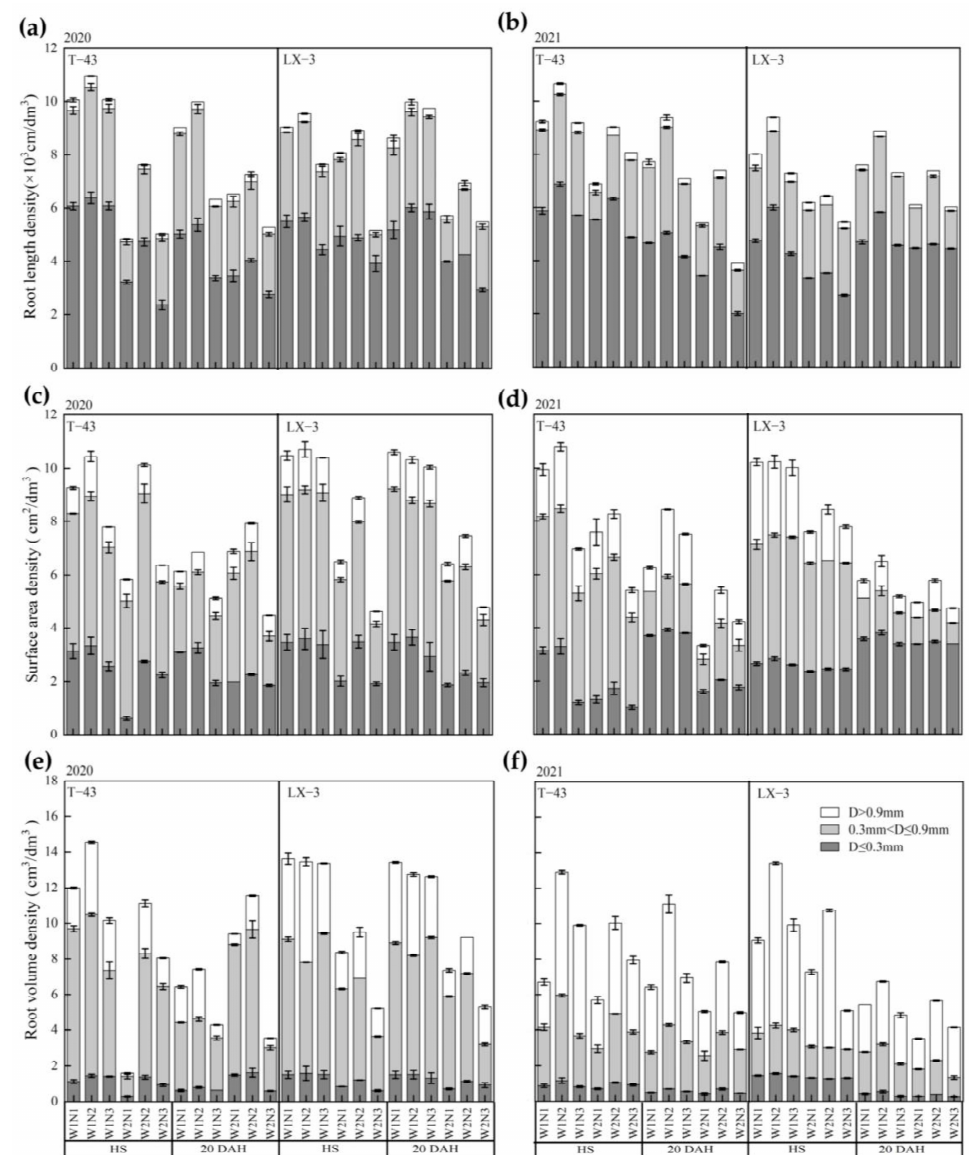
Figure 3. E ff ects of Water and Nitrogen Application on Root Morphological Indexes of Rice under Drip Irrigation. T-43: nitrogen-efficient variety, LX-3: nitrogen-inefficient variety; W and N repre- sent water and nitrogen management, respectively, W 1 : 10200 m 3 /hm 2 , W 2 : 8670 m 3 /hm 2 ; N 1 (seed- ling: tiller: panicle: grain fertilizer 30%:50%:13%:7%), N 2 (seedling: tiller: panicle: grain fertilizer